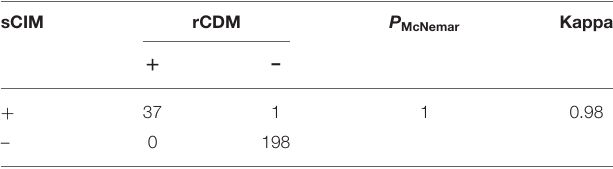
TABLE 7 | The statistic results of sCIM and rCDM for 236 P. aeruginosa